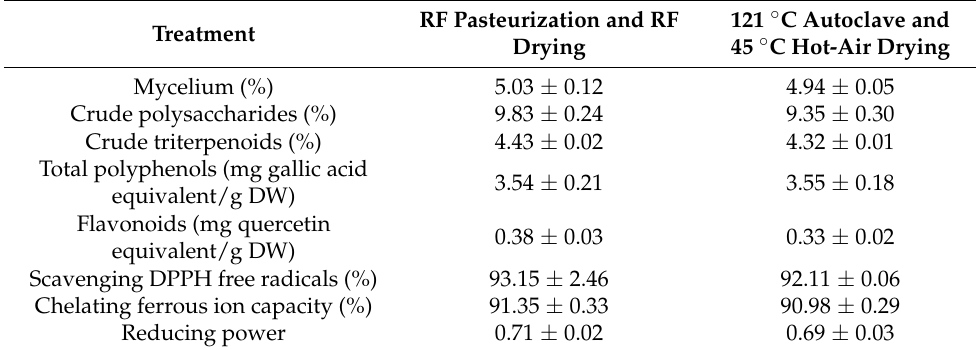
Table 1. Effect of different pasteurization and drying methods on the active components and antioxi- dant activity of the solid-state fermented W. cocos